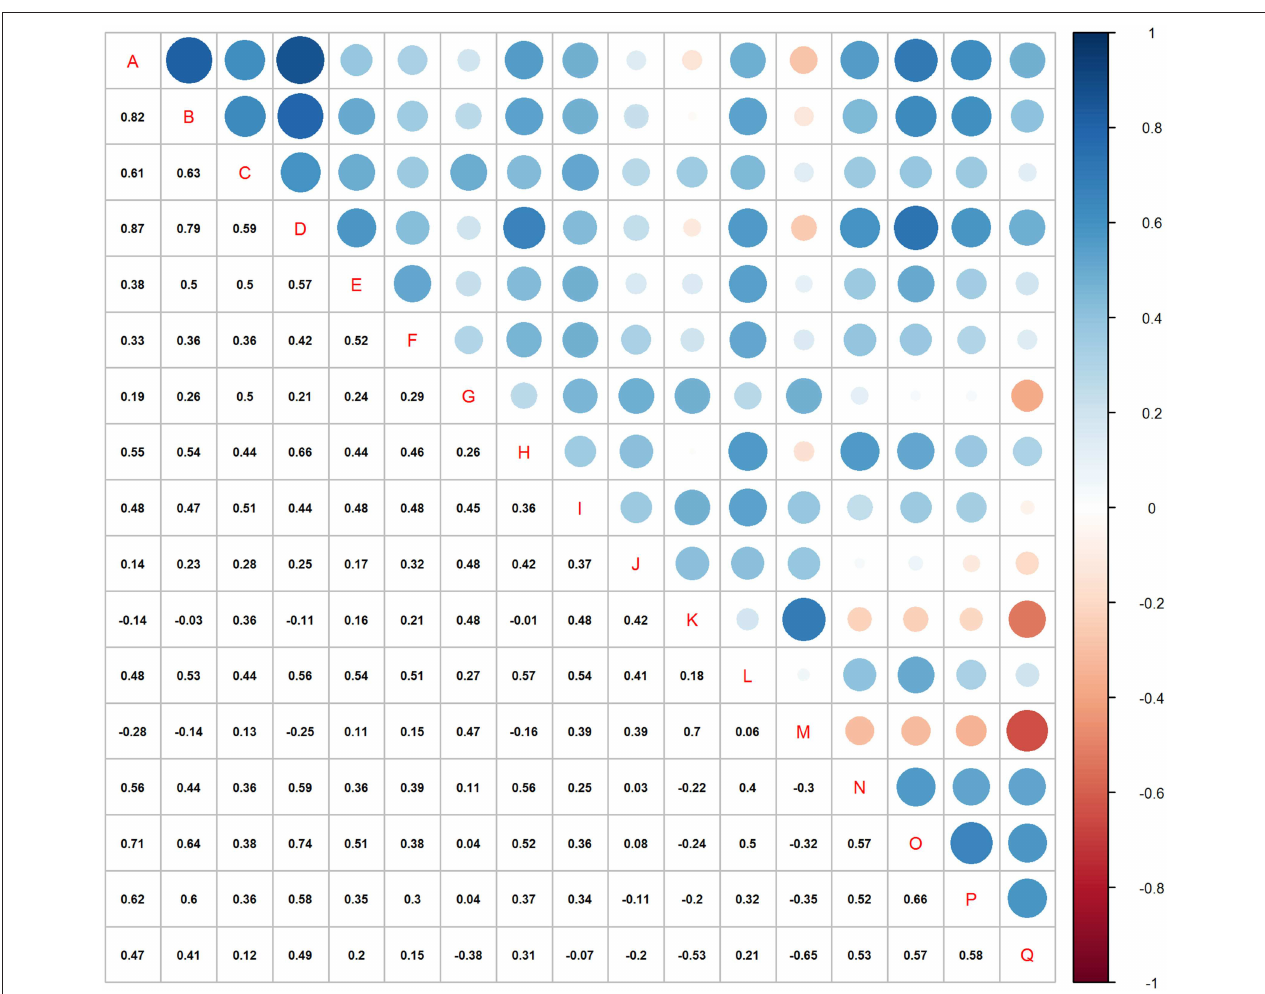
FIGURE 4 | Correlation matrix for all 17 variables in the analyses. See Table 2 for variable name